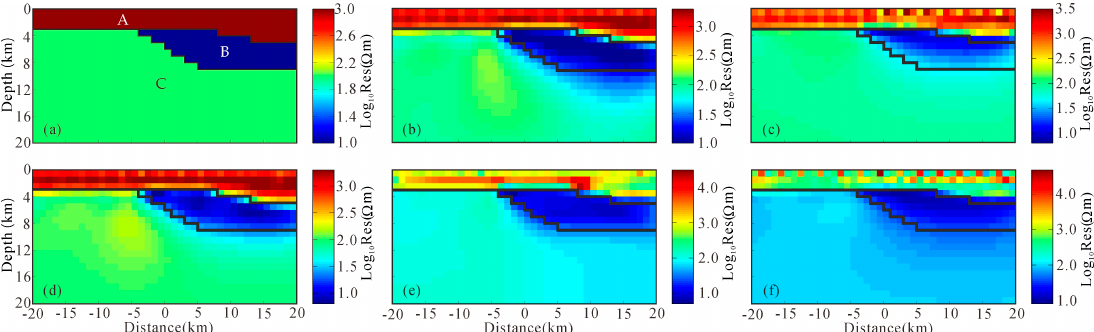
Figure 1. MT separate inversion results obtained using different regularization methods. ( a ) Resistivity true model; ( b ) Resistivity inversion model using L2 regularization; ( c ) Resistivity inversion model using L1 regularization; ( d ) Resistivity inversion model using elastic-net regularization; ( e ) Resistivity inversion model using TV regularization; ( f ) Resistivity inversion model using focusing regularization. The black box indicates the boundary of the anomalous body.